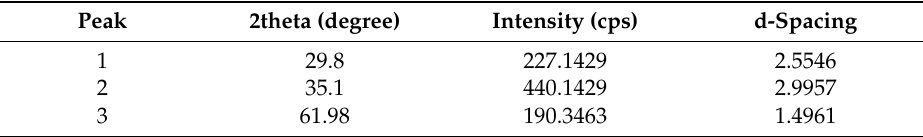
Figure 2. XRD spectrum of zinc ferrite and highlighted peaks attributable to the Franklinite phase. Table 3. Characteristic peaks of zinc ferrite and attributed to Franklinite.